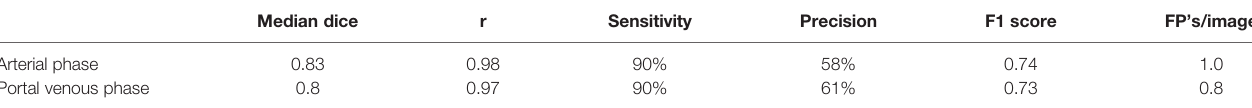
TABLE 5 | Results of ablation zone segmentation model.